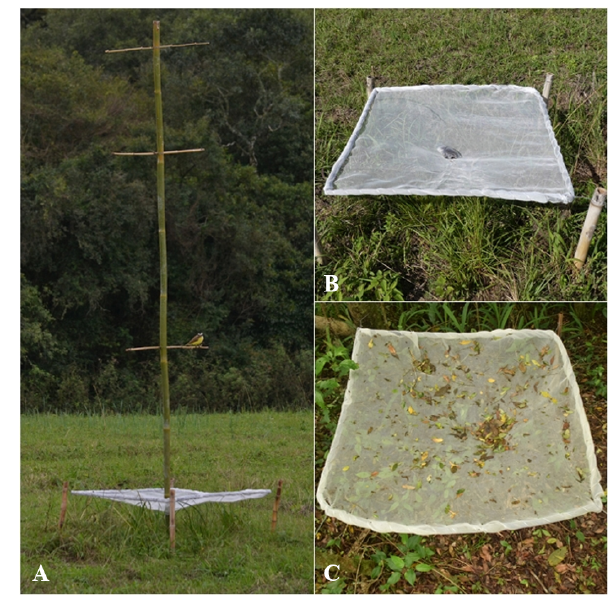
Figure 2. (a) Artificial perch in a triple T shape and seed trap; (b) control seed trap; (c) forest seed traps inside the riparian for-